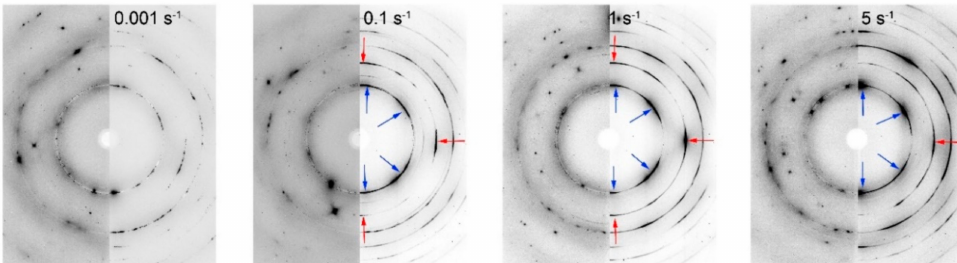
Figure 5. Half Debye-Scherrer rings before (left) and after (right) deformation at 0.001, 0.1, 1, and 5 s − 1 . Arrows indicate the high intensity spots for β -110 (blue) and β -200 (red) planes after deformation. Load direction is horizontal and radial direction is vertical.